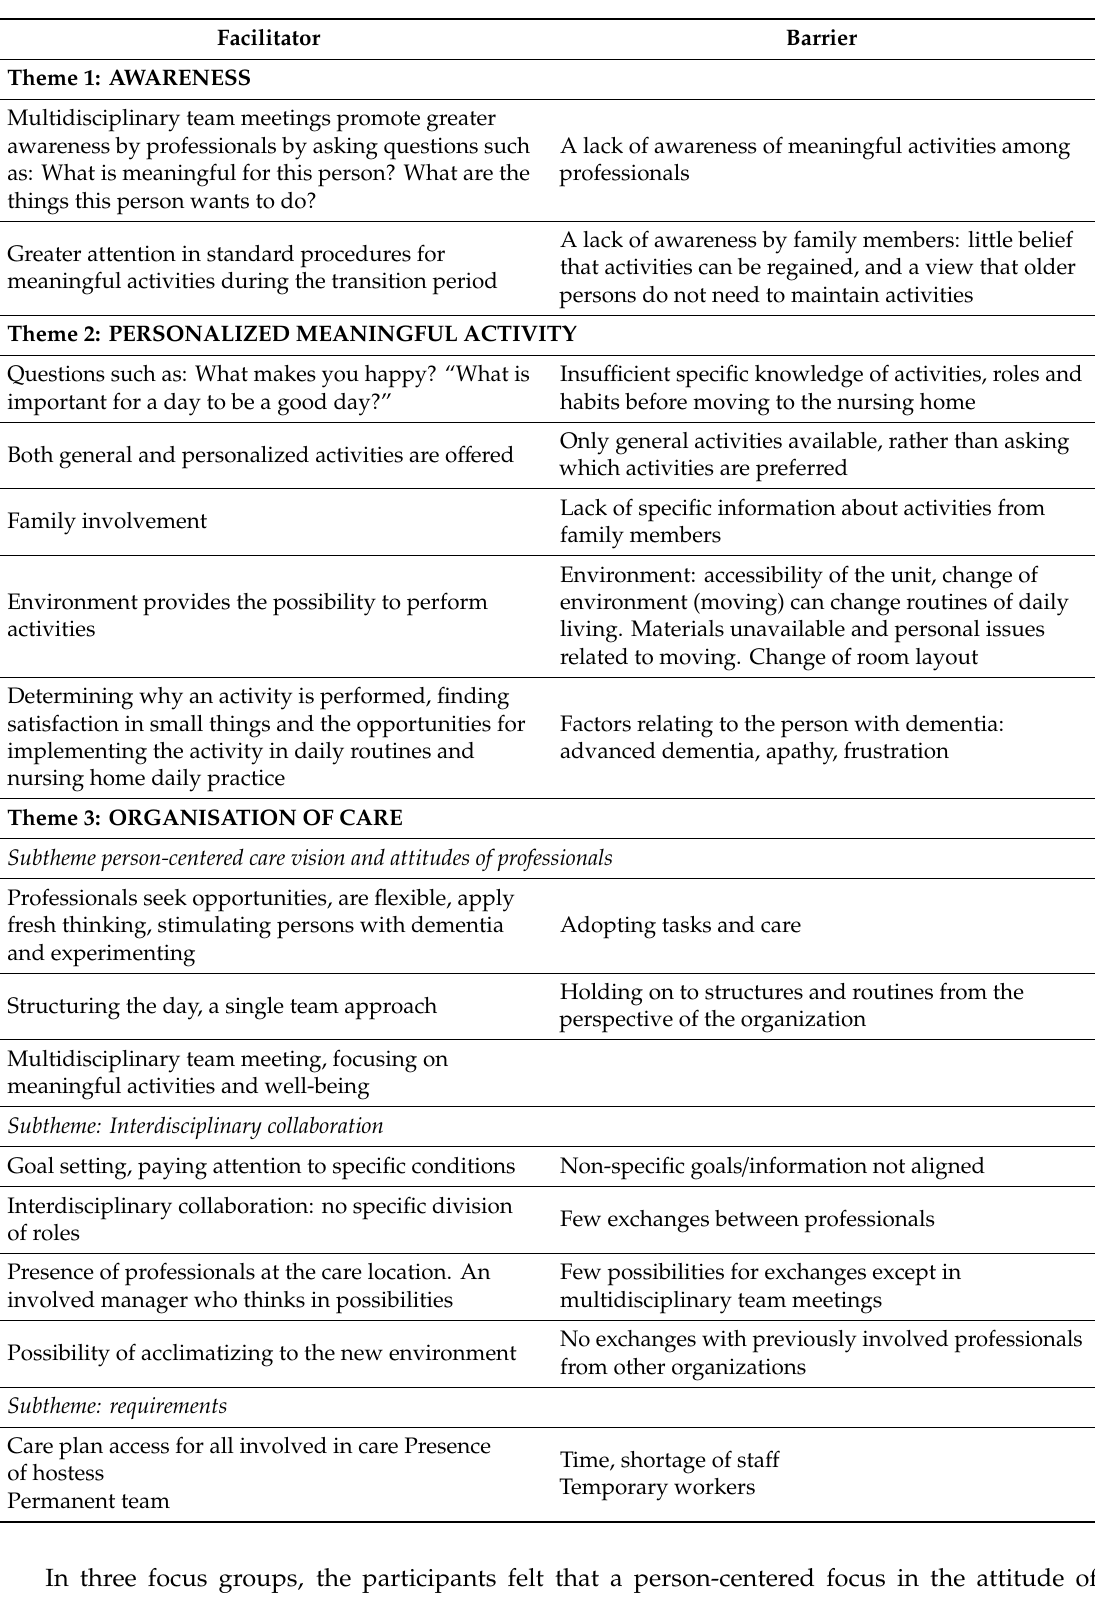
Table 2. Facilitators and barriers to maintaining meaningful activities in the transition period as experienced by healthcare